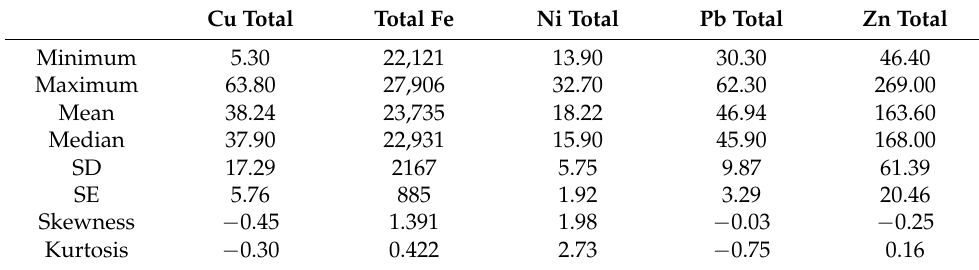
Table 1. Overall values of concentrations (mg/kg dry weight) for Cu, Fe, Ni, Pb and Zn, of